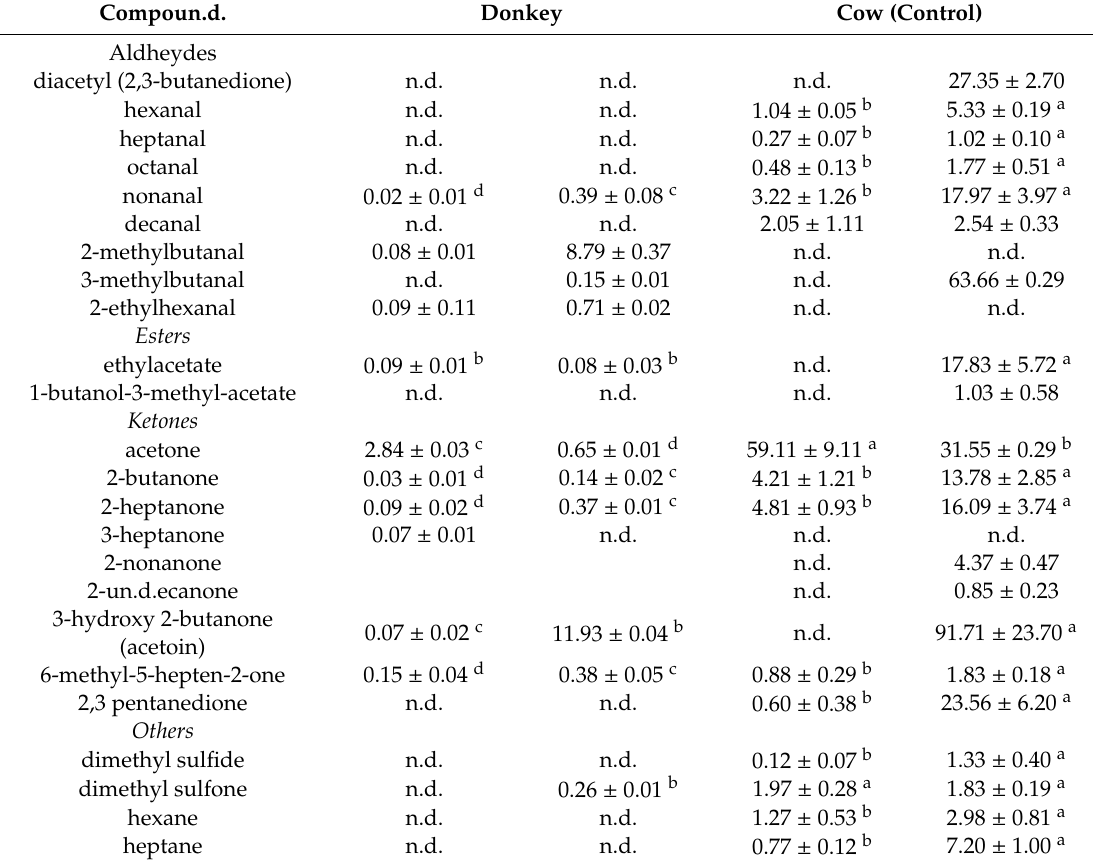
Table 4. Volatile organic compounds (VOCs) detected in milk and cheese ( µ g / kg ± SD). Compoun.d. Donkey Cow (Control) diacetyl